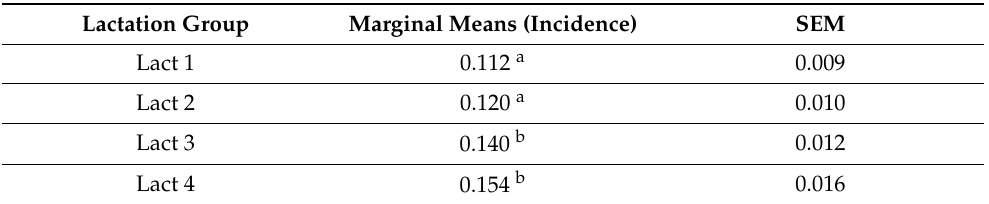
Table 6. Least squares means for lactation groups (n = 4) abortion incidence ( p < 0.0001), and SEM. a,b Different letters within the same column represent p < 0.05.